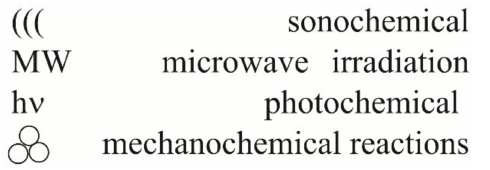
Figure 2. Symbolic representations of the different solid state-chemistry synthetic methods. Adapted with permission from [101], Royal Society of Chemistry,